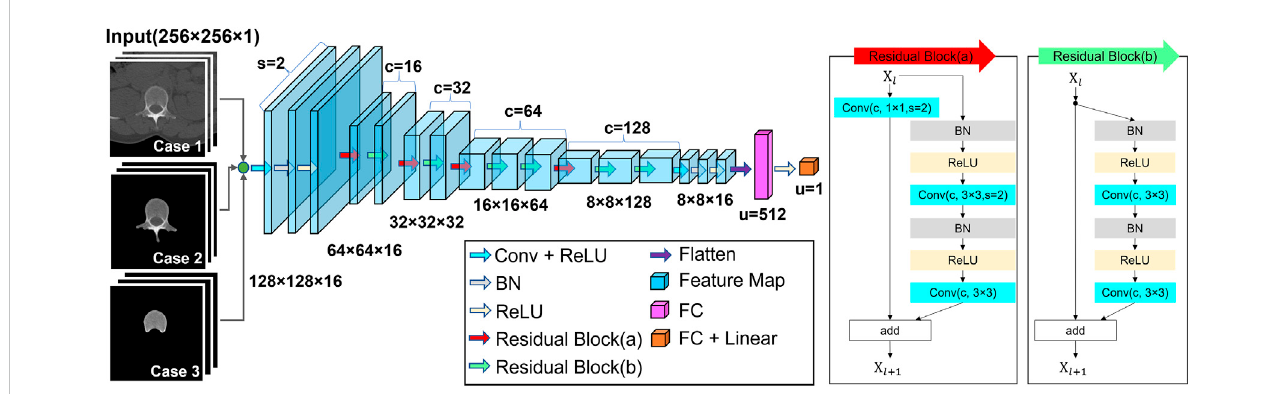
FIGURE 3 Schematic of the residual CNN structure. Inputs are either cropped images or bone-segmented images, and outputs are BMD estimates. When the residual block reduces the size of the feature map, the self-replicating stream has down-sampling using the 1 × 1 convolution with a stride of two. The meaningsoftheabbreviationsareasfollows:Conv,convolutionallayer;BN,batchnormalization;s,strides;c,channelofconvolutionallayer,andu,numberof units.